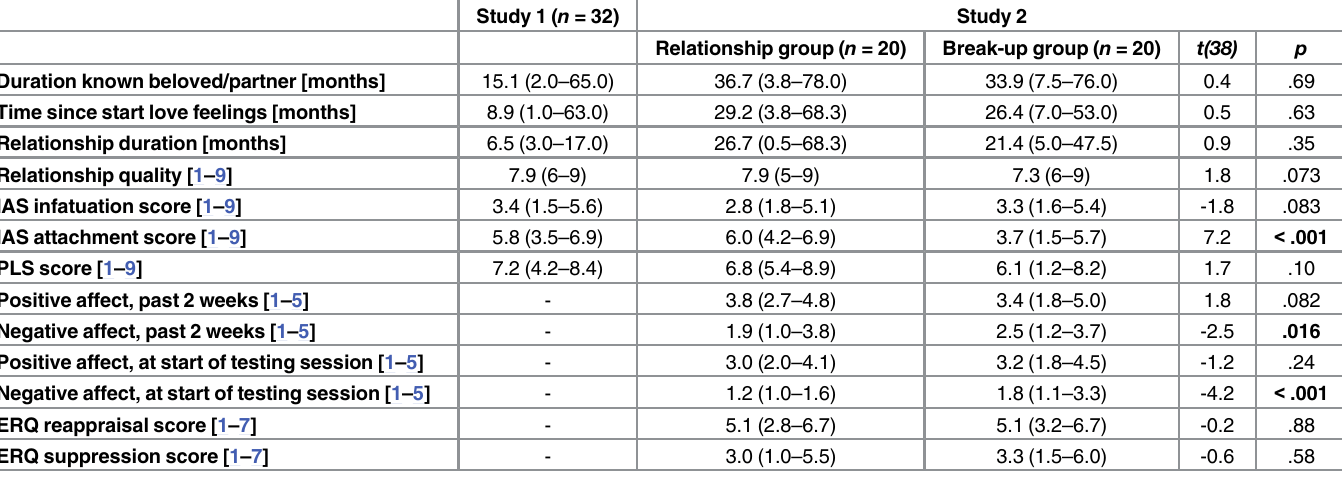
Table 3. Participant characteristics. Means (ranges in parentheses).